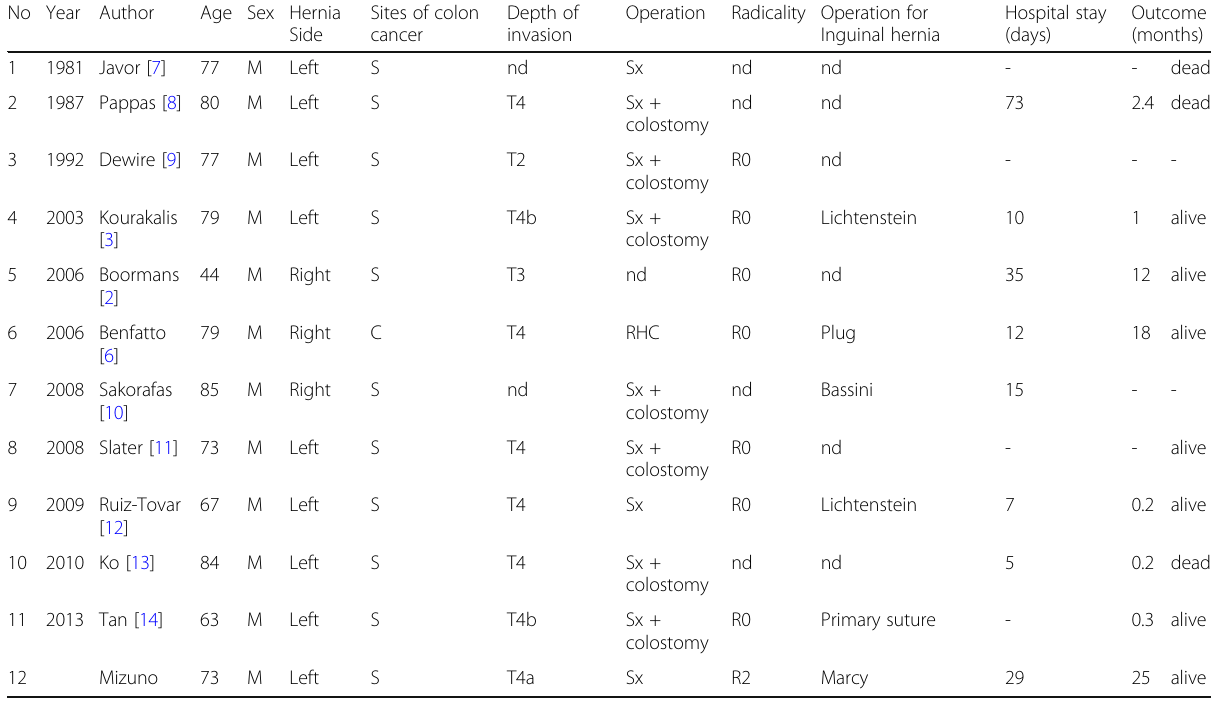
Table 1 Reported cases of a perforated malignant tumor in an inguinal hernia sac No Year